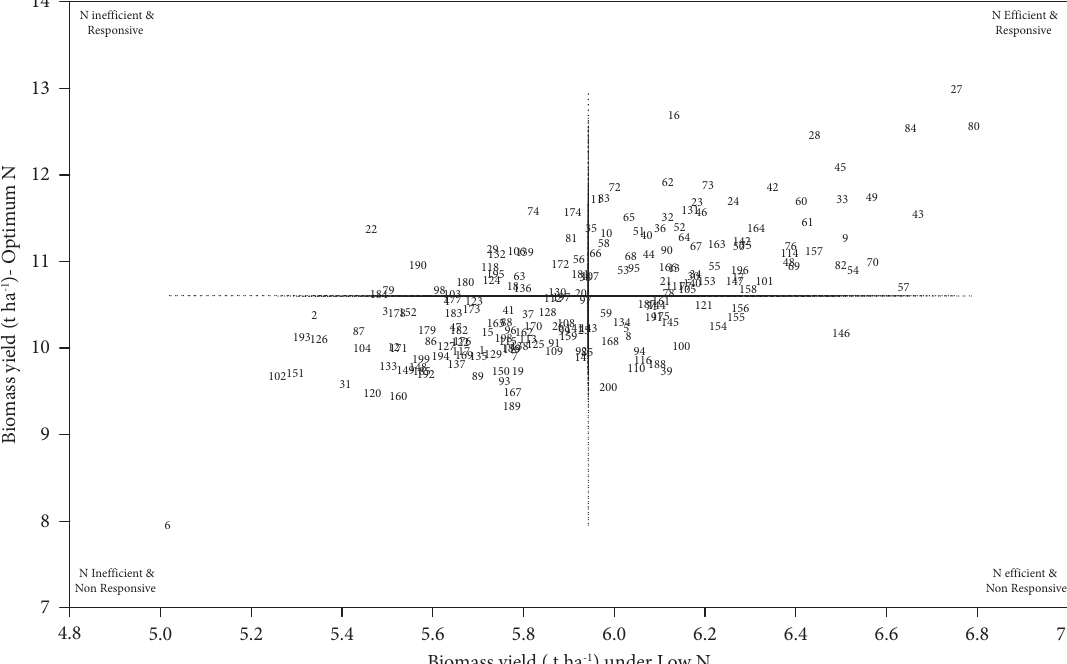
Figure 3: Categorization of N-efcient and N-responsive durum wheat genotypes based on above-ground total biomass yield. Horizontal and vertical broken lines depict the mean biomass yield under low and optimum N conditions, respectively.